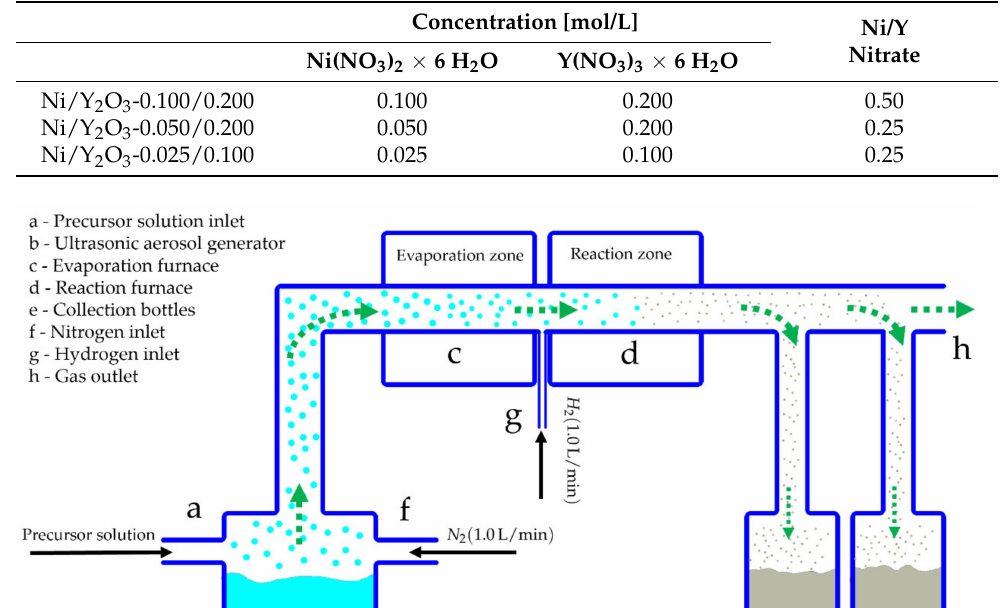
Table 1. Experimental plan for preparation of the Ni/Y 2 O 3 precursor solutions.